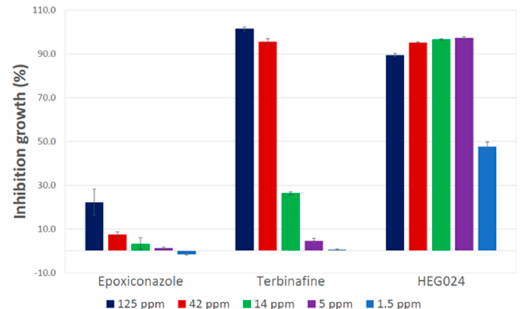
Figure 5. Inhibition percentage of growth of P. infestans by the crude extract (HEG024) from the culture broth of C. virescens in vitro at different concentrations in ppm, after eight days of pathogen inoculation. Epoxiconazole and Terbinafine were used as positive control. Mean and standard deviation is expressed in the error bar (n = 3). The antagonistic effect of the crude ethyl acetate extract from the culture broth of C. virescens against B. cinerea is presented in Figure 6. The crude extract expressed low activ- ity compared with Epoxiconazole and Terbinafine.